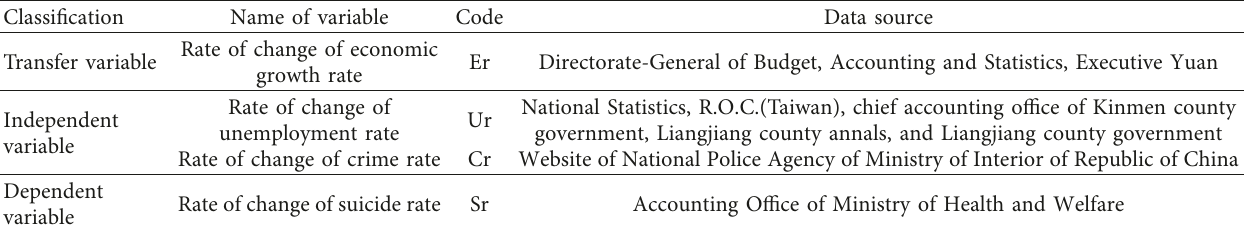
Table 1: Classification, name, code, and data source of research variables.